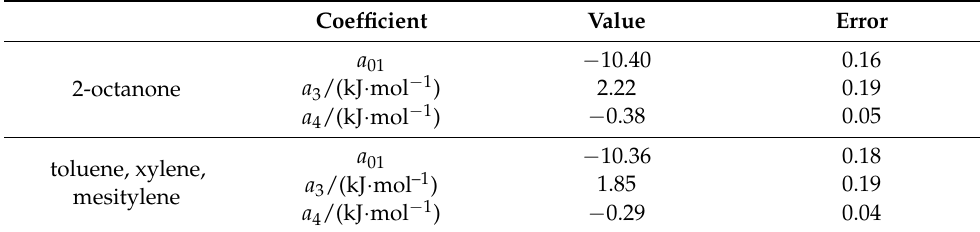
Table 5. Estimated coefficients a 01 , a 3 , and a 4 of the model represented by Equation (13) for polymer- izations in the indicated solvents with equimolar amounts of monomer and solvent at 130 ◦ C. a 2 was set to 1.28.